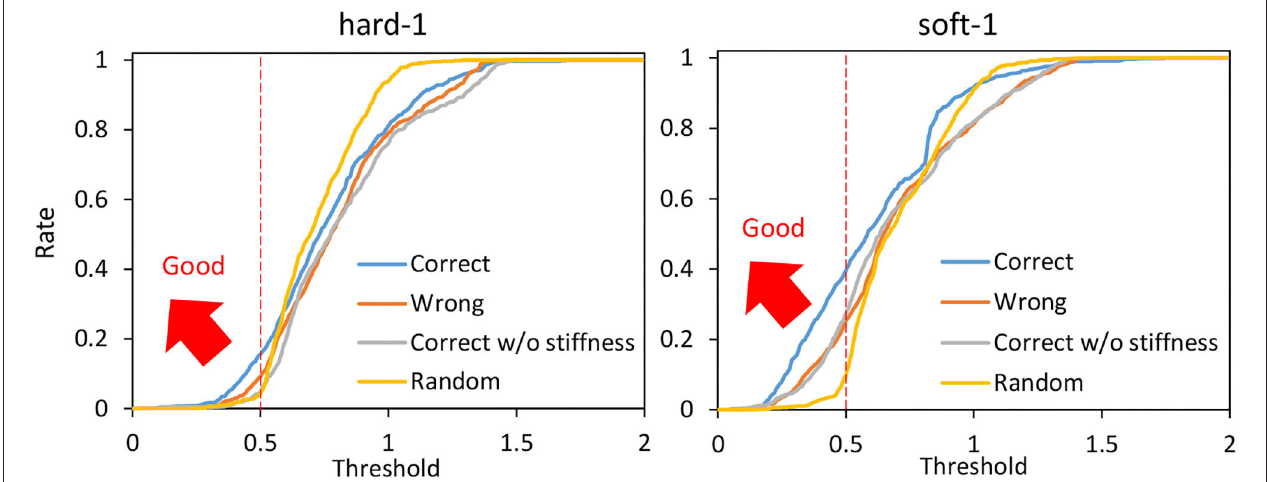
FIGURE 13 | Actual robot experiment: the rate (y-axis) of || z ref − z || 2 < threshold (x-axis) when conducting experiments of dynamic manipulation of hard-1 and soft-1 regarding Correct, Wrong, Correct without stiffness, and